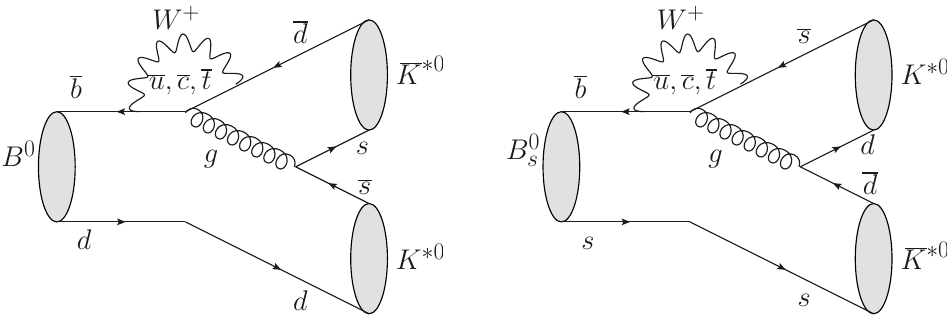
Figure 1 . Leading order Feynman diagrams for the B 0 modes are dominated by a gluonic-penguin